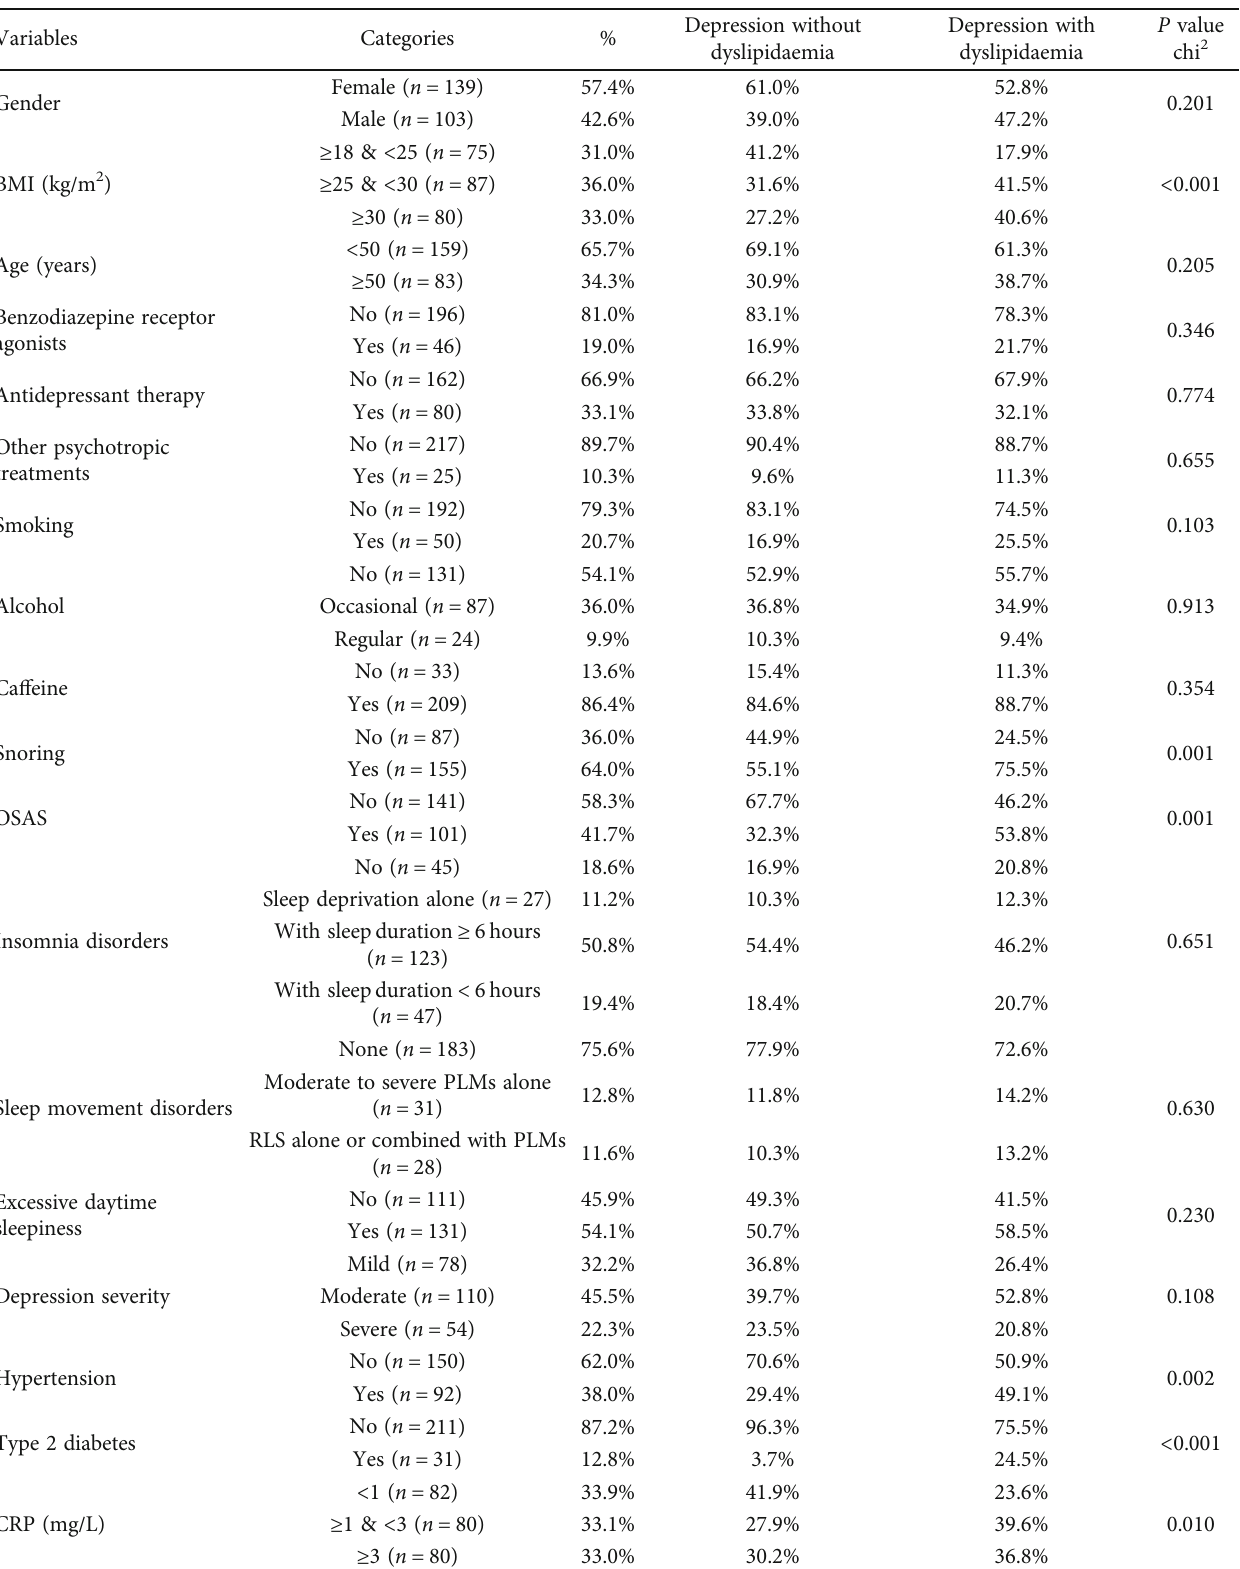
Table 2: Sample description ( n = 242